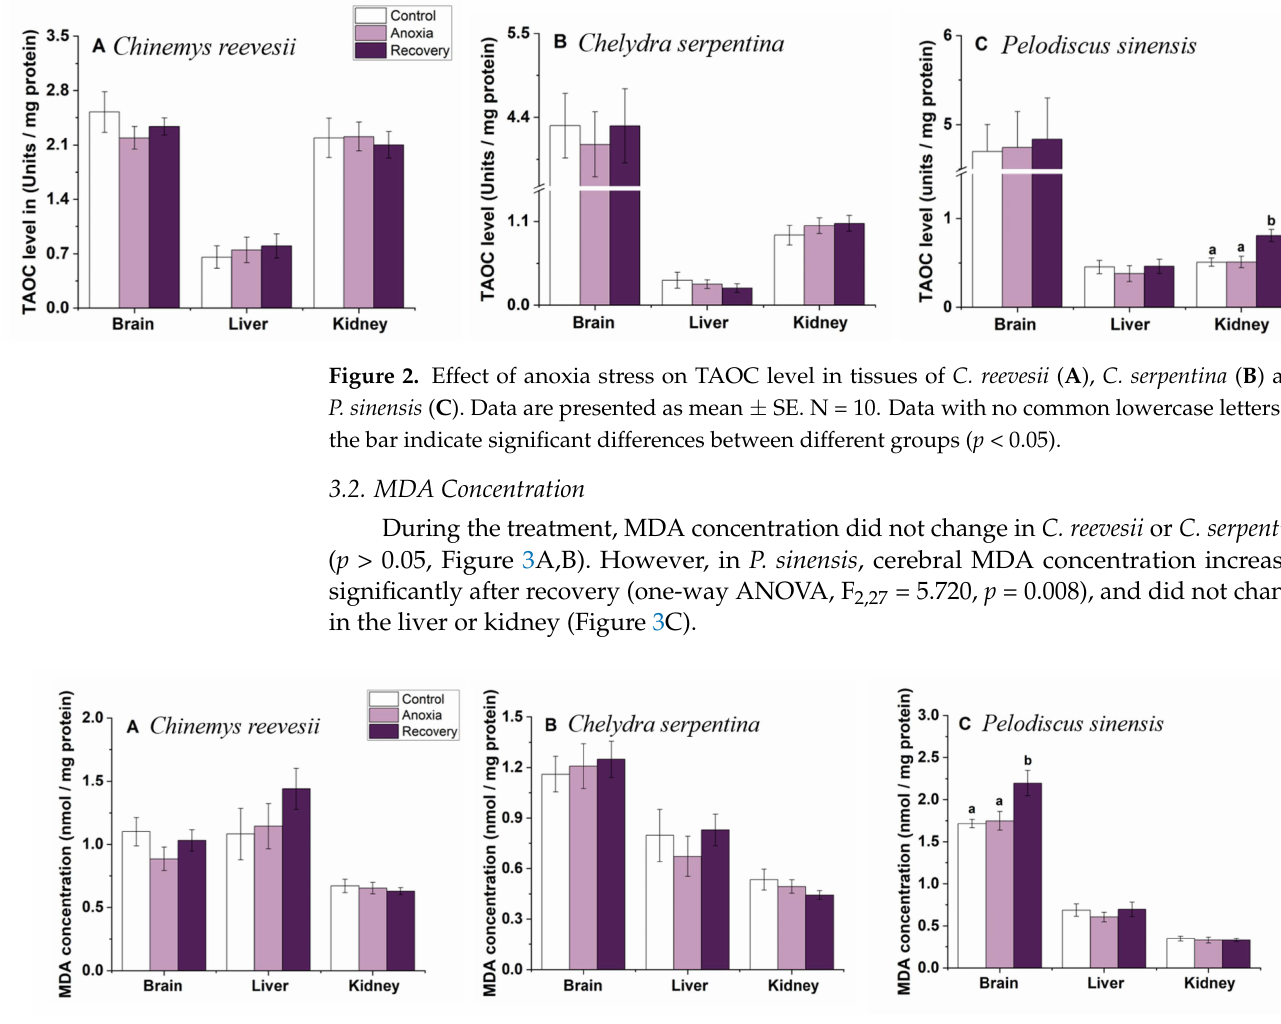
Figure 3. Effect of anoxia stress on MDA concentration in tissues of C. reevesii ( A ), C. serpentina ( B ) and P. sinensis ( C ). Data are presented as mean ± SE. N = 10. Data with no common lowercase letters on the bar indicate significant differences between different groups ( p <